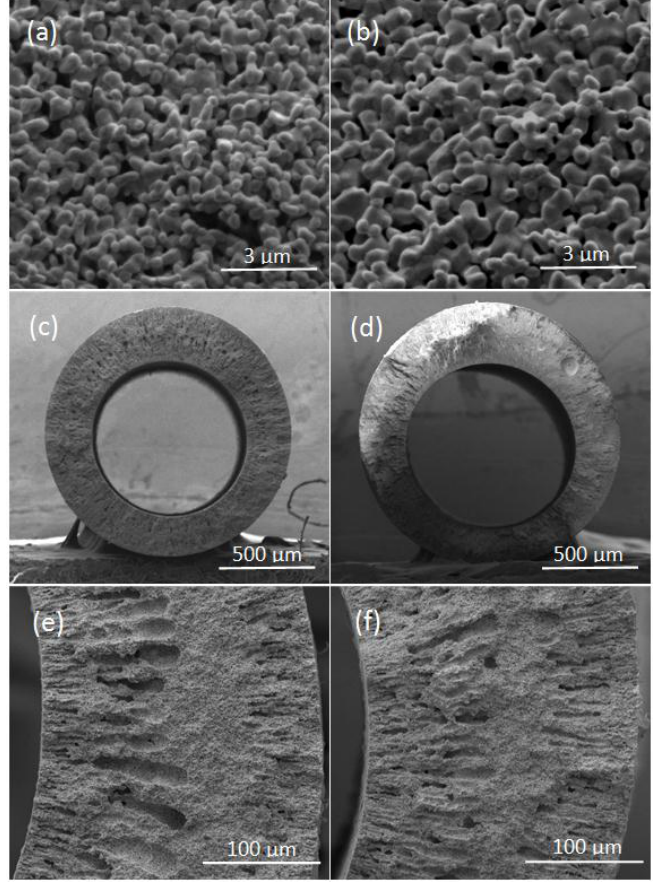
Figure 2. The morphologies of the as-sintered alumina hollow membrane sintered at different temperatures: outer surface sintered at ( a ) 1400 ◦ C and ( b ) 1500 ◦ C; cross-sectional sintered at ( c ) 1400 ◦ C and ( d ) 1500 ◦ C; partial cross-sectional sintered at ( e ) 1400 ◦ C and ( f ) 1500 ◦